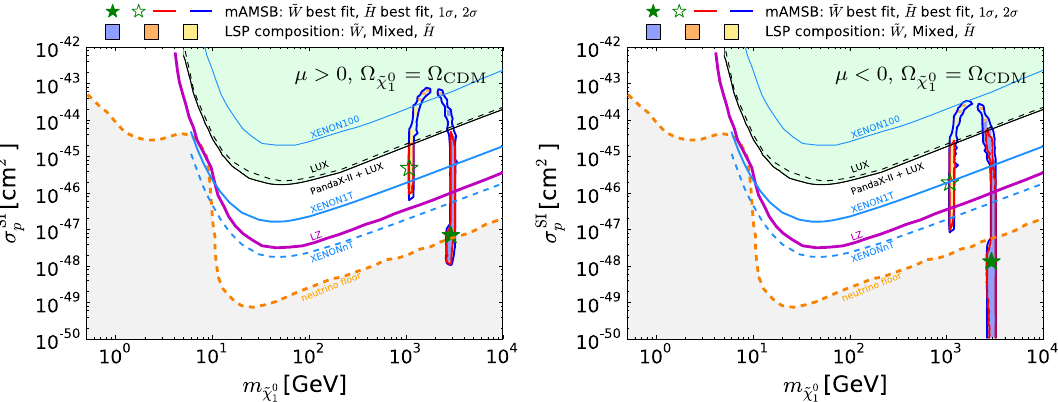
,σ SI ) planesinthemAMSBfor μ > 0( left )and μ < Fig. 26 The ( m ˜ χ 0 p 1 0 ( right ) in the case when the LSP accounts for the whole DM density. The red and blue solid lines are the 1 and 2 σ CL contours, and the solid purple and blue lines show the projected 95% exclusion sensitivities of the LUX-Zeplin (LZ) [153] and XENON1T/nT experiments [154,155],